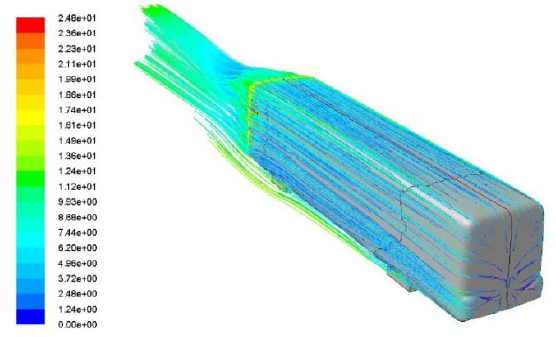
Fig. 6. Streamlines based on velocity [m/s] – view of the bus from the front of the vehicle on the side of radiator mounting